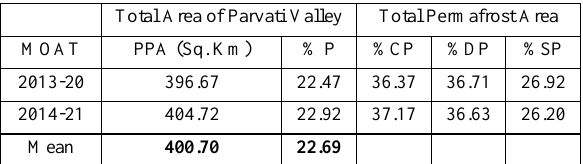
Table 7: The table summarizing the total probable permafrost area (in Sq. Km and %) and the percentage of permafrost area in different categories (CP, DP, SP) using MOAT for each consecutive years starting from 2013 to 2021.